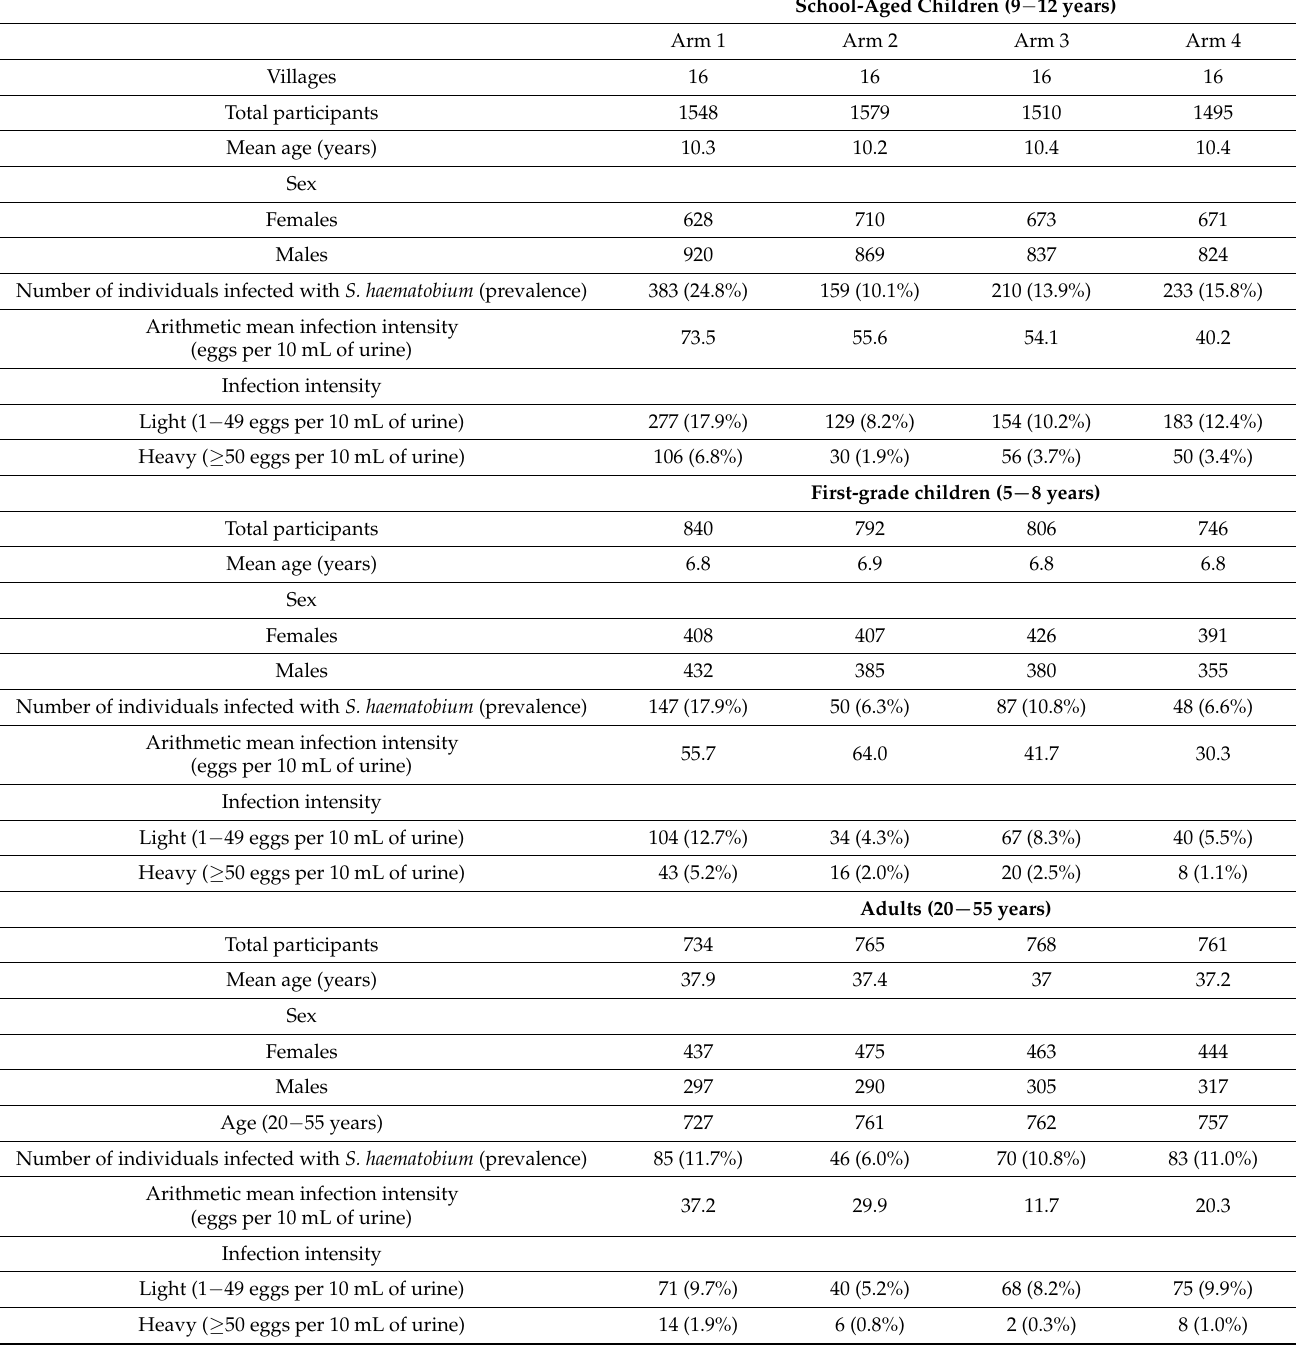
Table 1. Baseline characteristics of a cluster randomized trial pertaining to interruption of S. haematobium transmission in the northern and central parts of C ô te d’Ivoire, stratified by population